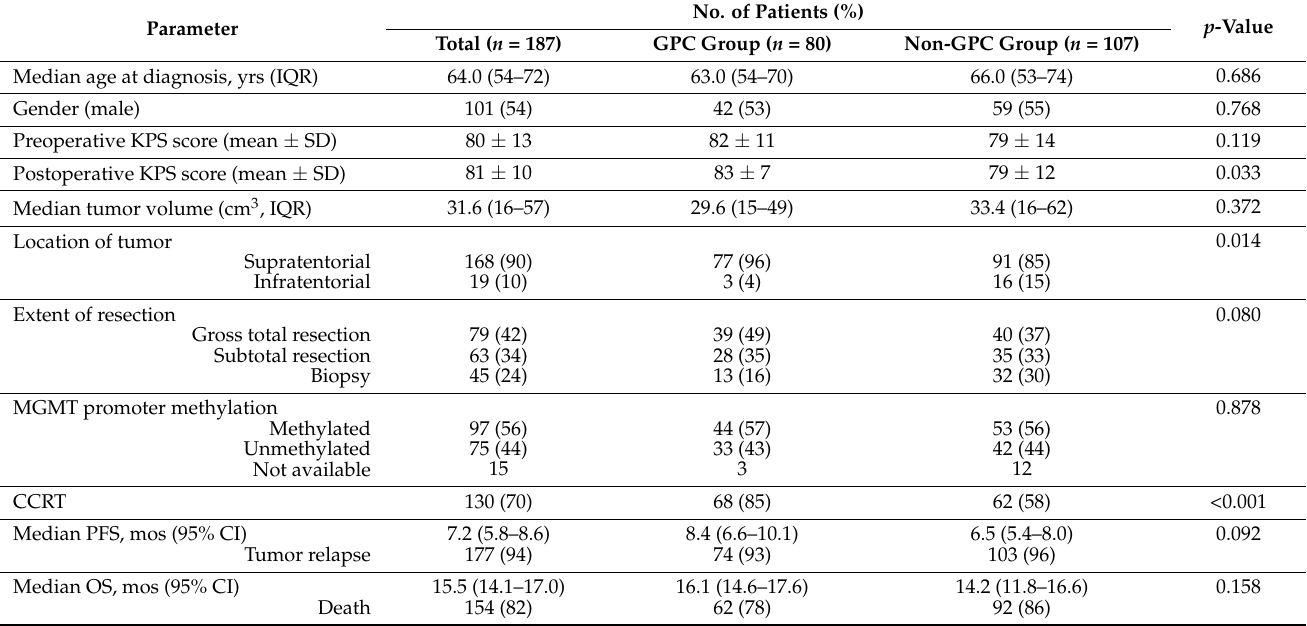
Table 1. Patient demographics according to the use of GPC ( ≥ 3 mos) ( n =